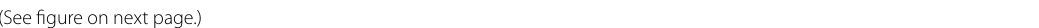
- developed model did not